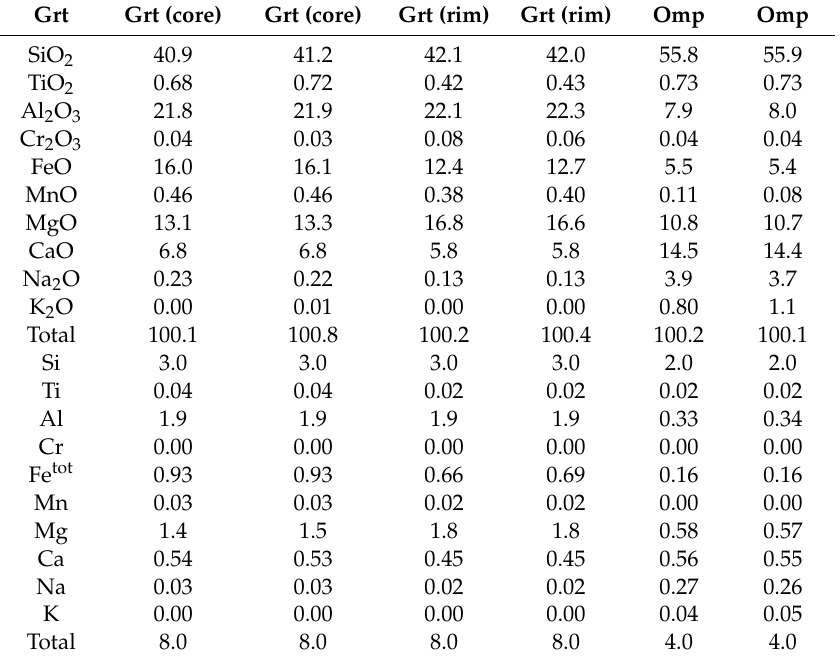
Table 1. Representative major-element concentrations (wt%; EPMA analyses) for garnet core-rim (Grt) and omphacite (Omp) in diamondiferous coesite-bearing eclogite xenolith from the Udachnaya kimberlite pipe.